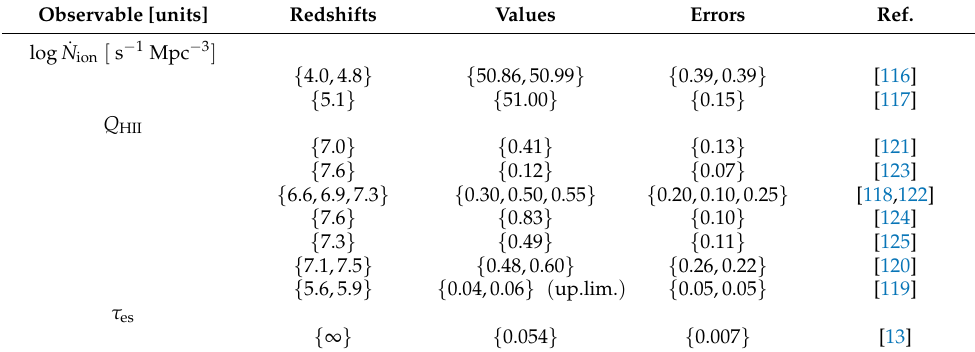
Table 2. Overview of the data considered in the Bayesian analysis of this work, referring to the ionizing photon rate ˙ N ion , volume filling fraction Q HII of ionized hydrogen, and optical depth τ es for electron